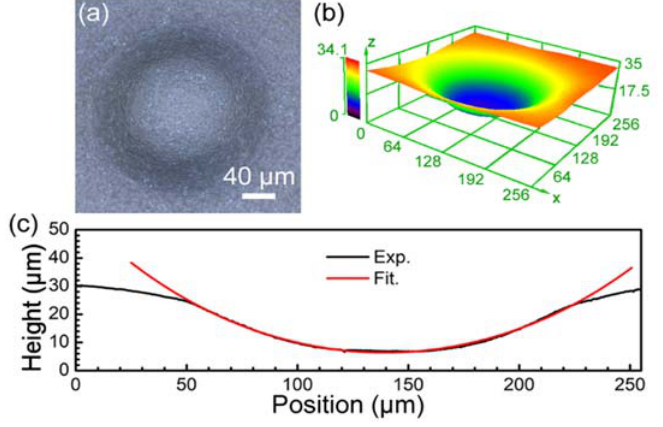
Figure 5. ( a ) LSCM image of concave microlens, ( b ) three-dimensional morphology, and ( c ) cross- sectional profile.